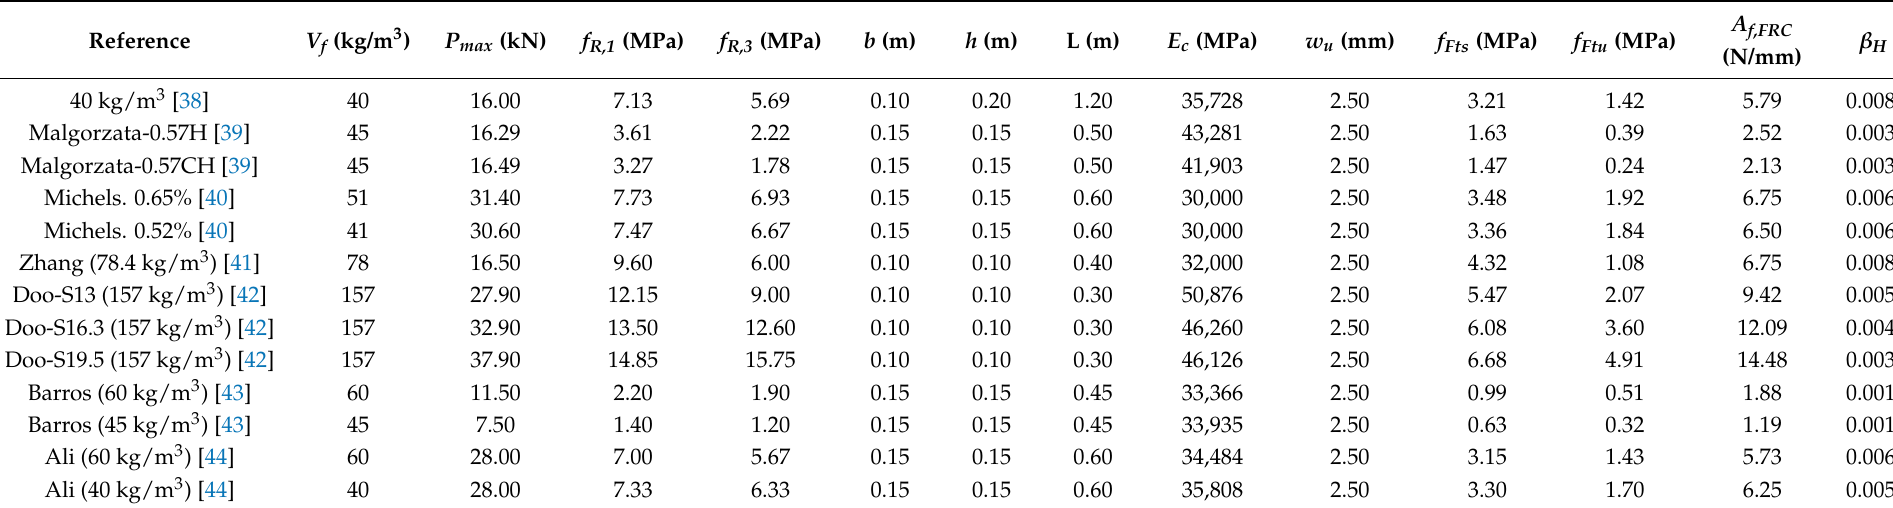
Table 1. Experimental results from the bibliography compared in Figure 6 with numerical results from the planar crack